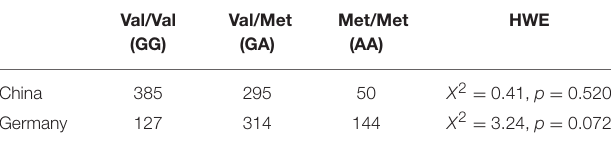
TABLE 1 | Genotype distributions of the COMT Val158Met polymorphism in the Chinese and German samples.